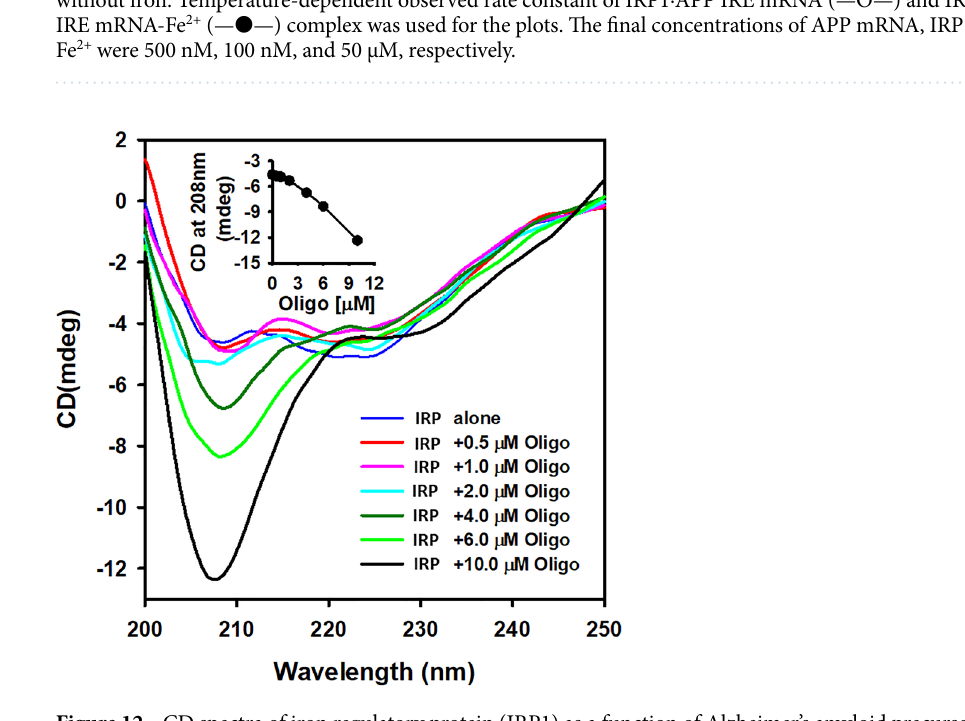
Figure 12. CD spectra of iron regulatory protein (IRP1) as a function of Alzheimer’s amyloid precursor protein (APP) IRE mRNA. The far-UV CD spectra were obtained using IRP1 protein concentration of 0.1 µM with addition of varying amounts of APP IRE mRNA (0 – 10